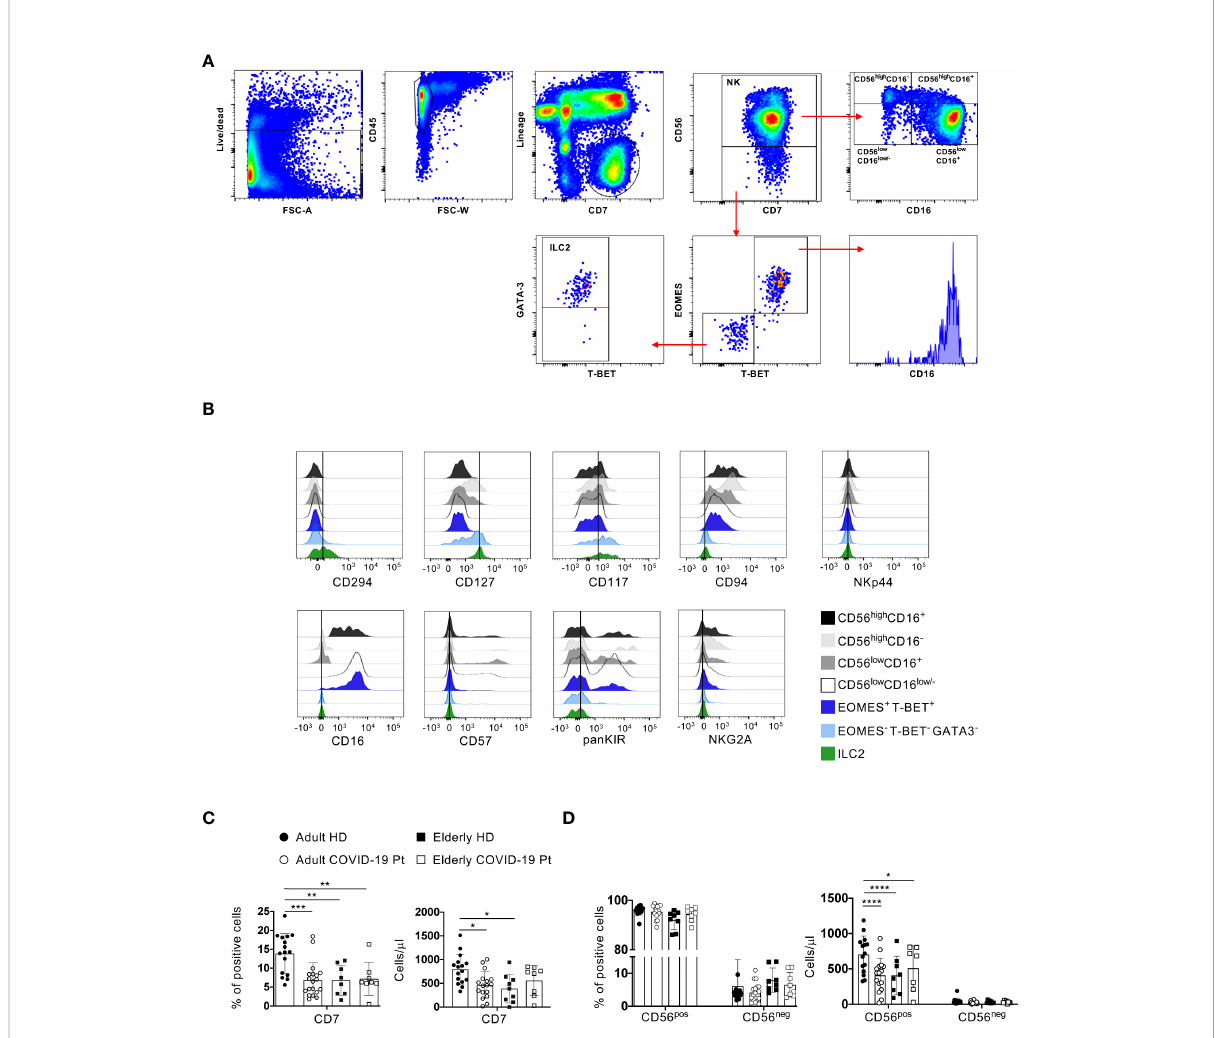
FIGURE 2 Changes in adult and elderly innate lymphocytes and NK cells during SARS-CoV-2 infection. (A) Gating strategy used to identify conventional NK cells (NK), CD56 neg EOMES + /T-BET + cells and ILC2. NK and EOMES - /T-BET - cells were gated on CD56 pos and CD56 neg NK cell